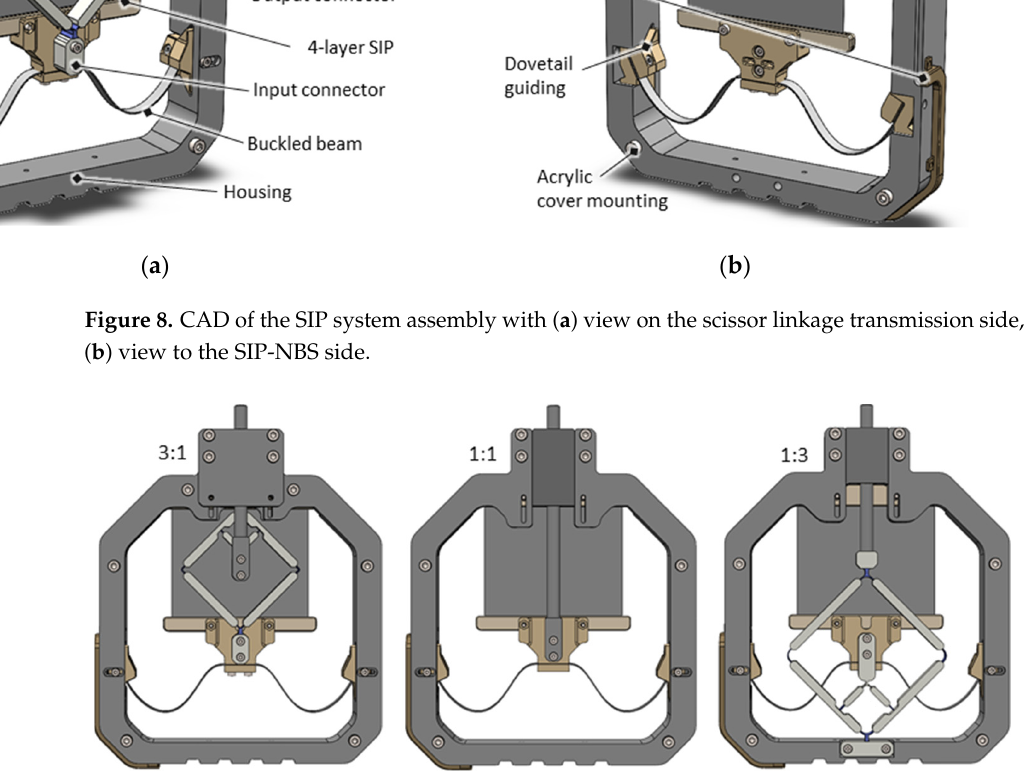
Figure 8. CAD of the SIP system assembly with ( a ) view on the scissor linkage transmission side, and ( b ) view to the SIP-NBS side.